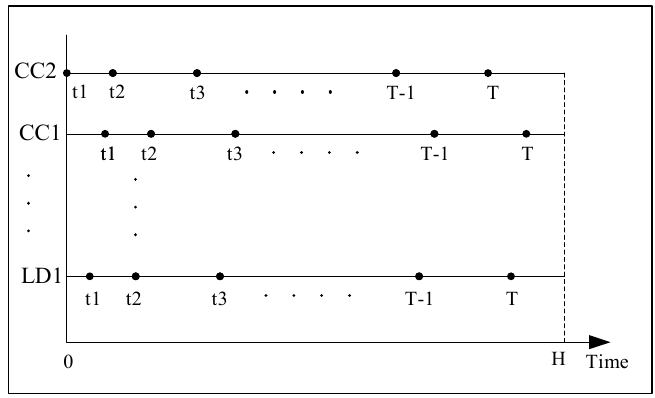
Figure 2. Continuous time representation based on unit specific event.